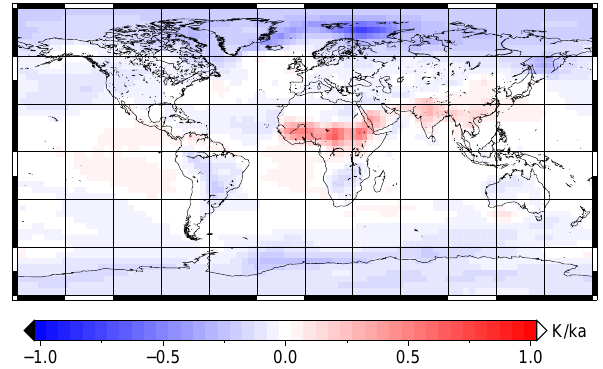
Fig. 2. Linear trend in seasonal cycle amplitude (difference between warmest and coldest month) over the simulation period in K/ka - Kelvin per 1,000 years.